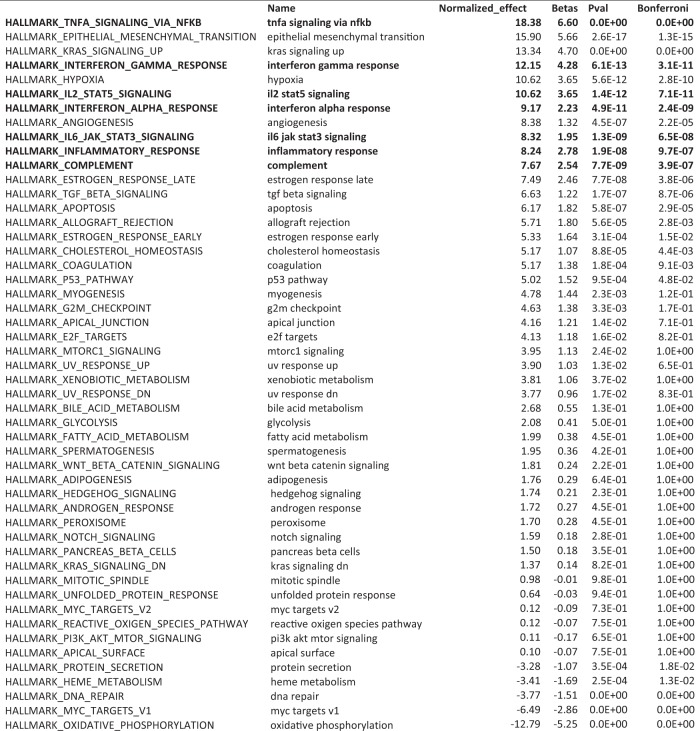
DLA identifies biological processes common to diseases that perturb the Lynx1−/− plasticity signature. To identify shared pathophysiology across the diverse list of diseases predicted to dysregulate the Lynx1−/− plasticity signature, we applied DLA. Large regression coefficients indicate that the biological pathway may disrupt Lynx1−/− plasticity. As with the juvenile plasticity signature, using a multiple test-corrected, empirical p < 5 × 10−5, we found that every inflammation-related gene set in the hallmark library was strongly associated with diseases that dysregulate plasticity genes (7 of 7 inflammation gene sets at pcorrected < 5 × 10−5: OR = 63.0, 95% CI = 3.2–1229.8, p = 7.6 × 10−5 Fisher’s exact test). A total of 20,000 permutations of the gene sets were used to estimate p values and to normalize the regression coefficients to allow comparison between effect sizes for different biological pathways. Inflammation-related gene sets: TNF-α signaling via NF-κB, IFN-γ response, inflammatory response, complement, IL-2–Stat5 signaling, IFN-α response, IL-6–Jak–Stat3 signaling.